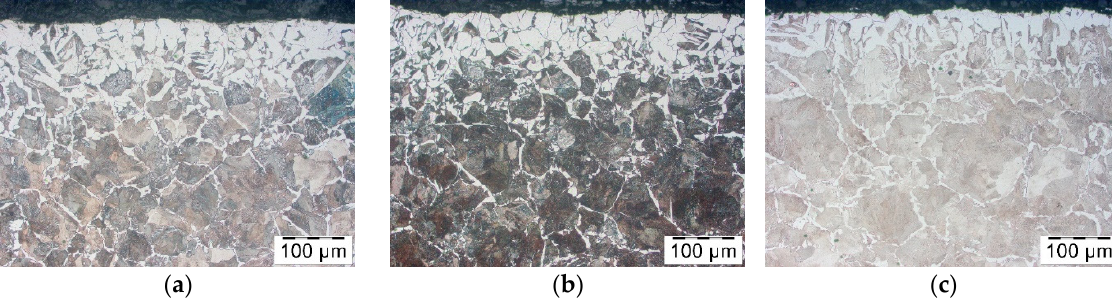
Figure 10. Microstructure in the surface layer of the forged part after hot forging and cooling—pre-coating in Berulite, in the concentration of ( a ) 100%, ( b ) 50% and ( c ) 33%.